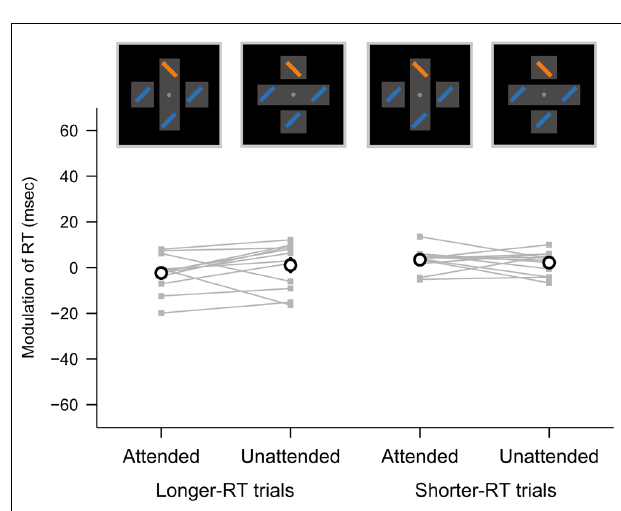
FIGURE 4 | Object-based modulation of RT in the parallel search task, obtained separately from longer- and shorter-RT trials. The same conventions are used as in Figure 3